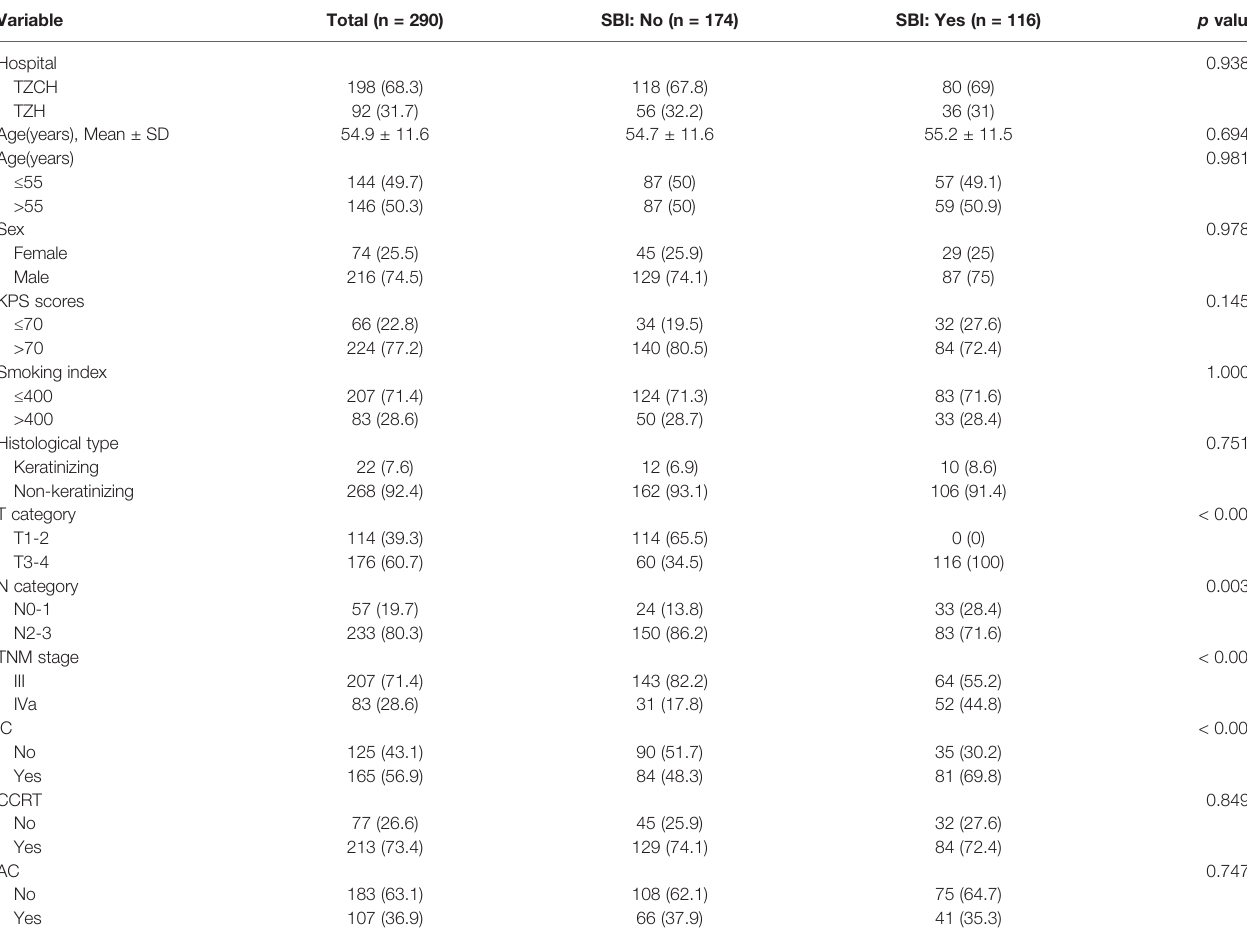
TABLE 1 | Baseline characteristics of 290 locally advanced nasopharyngeal carcinoma patients grouped by presence of skull base invasion. Variable Total (n = 290) SBI: No (n =